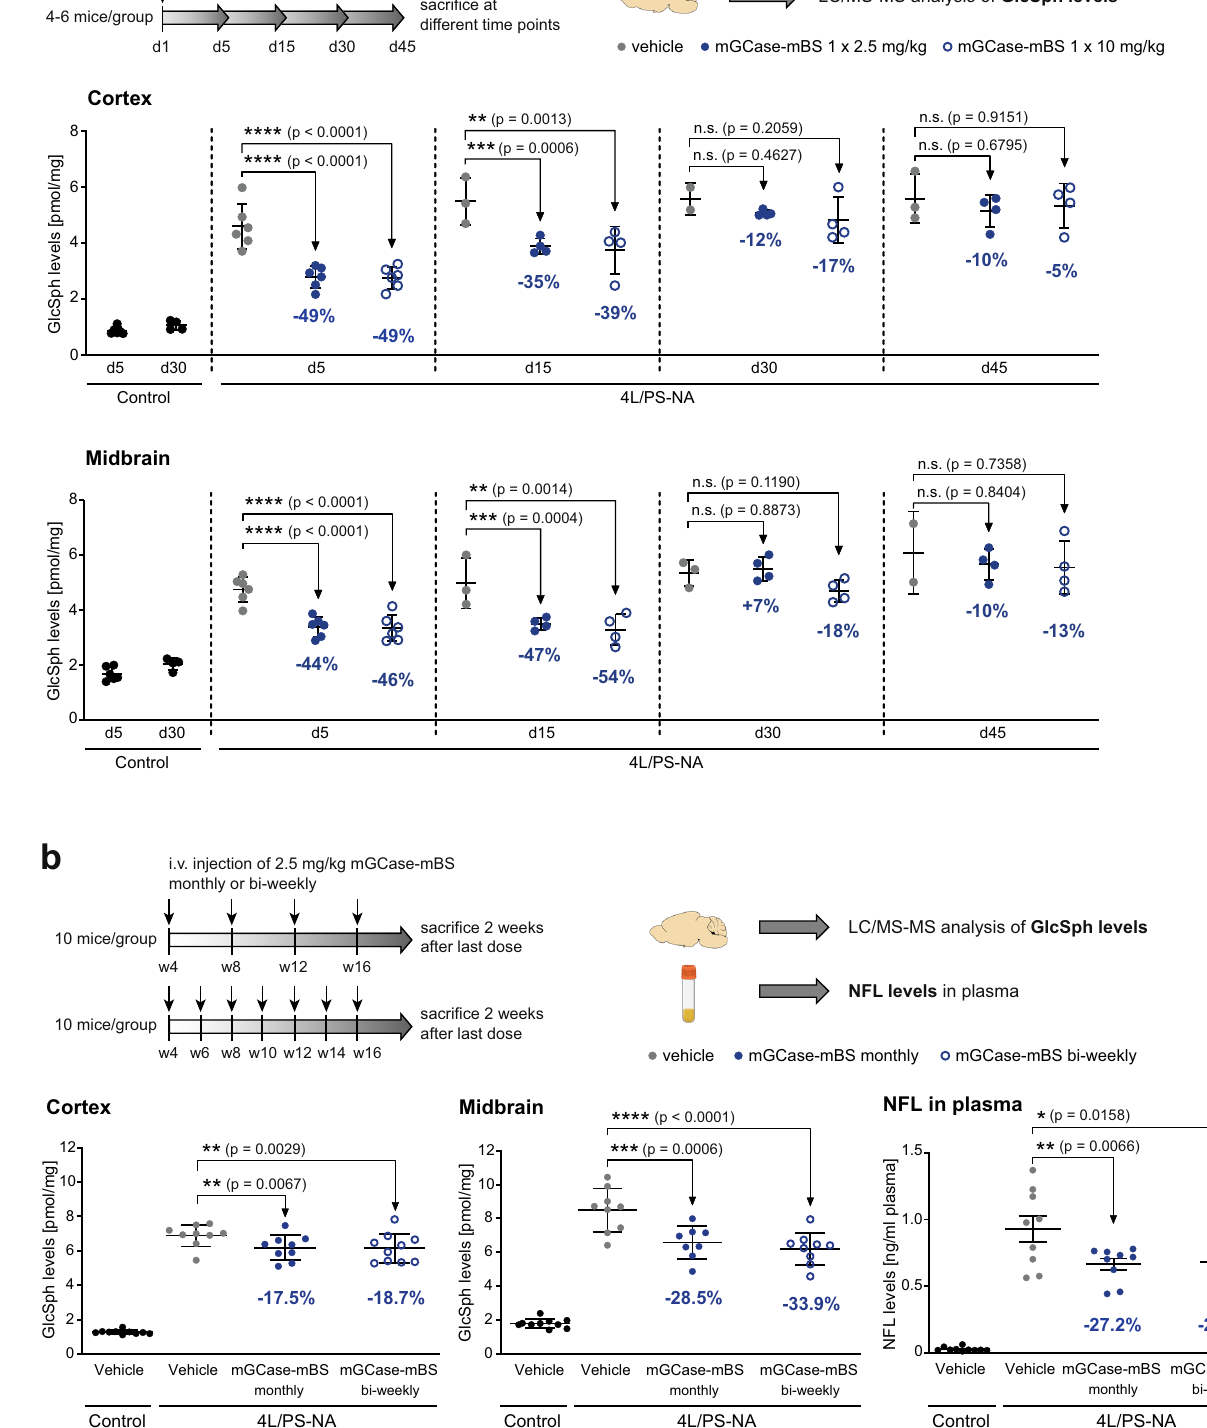
Fig. 7| GCase-BS longitudinaleffectsinvivo.a Single-dose PD studyin4L/PS-NA mice to inform about duration of GlcSph lowering in cortex and midbrain. GlcSph levels rebounce between 15 – 30 days post administration. n =4 – 6 mice/group.